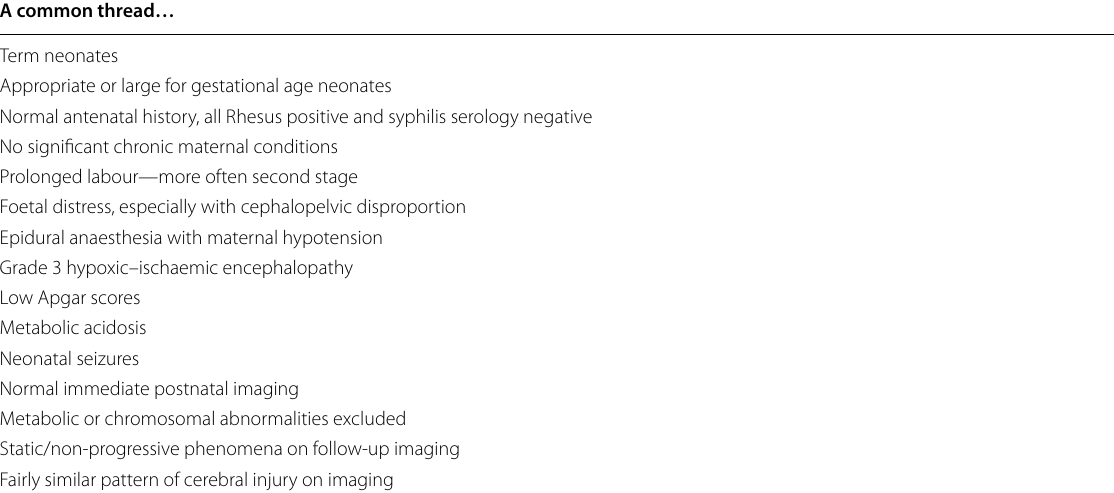
Table 5 The common findings in all 19 patients with MPI pattern